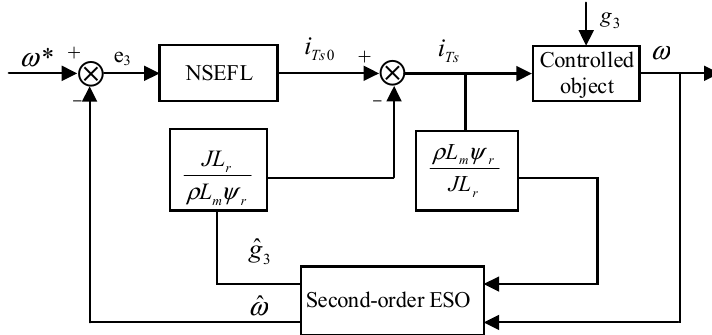
Figure 7. Structure of the active disturbance rejection system of the speed outer loop.